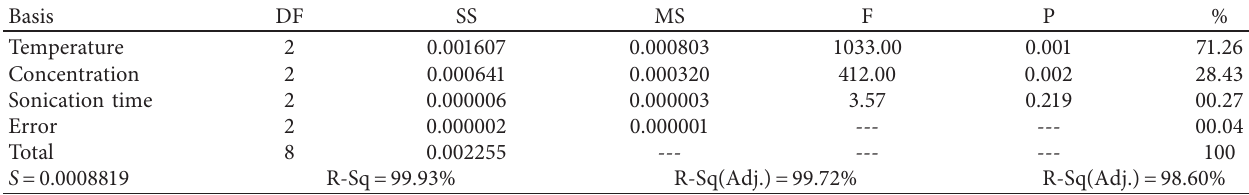
Table 4: Variance analysis for thermal conductivity (unmilled process).